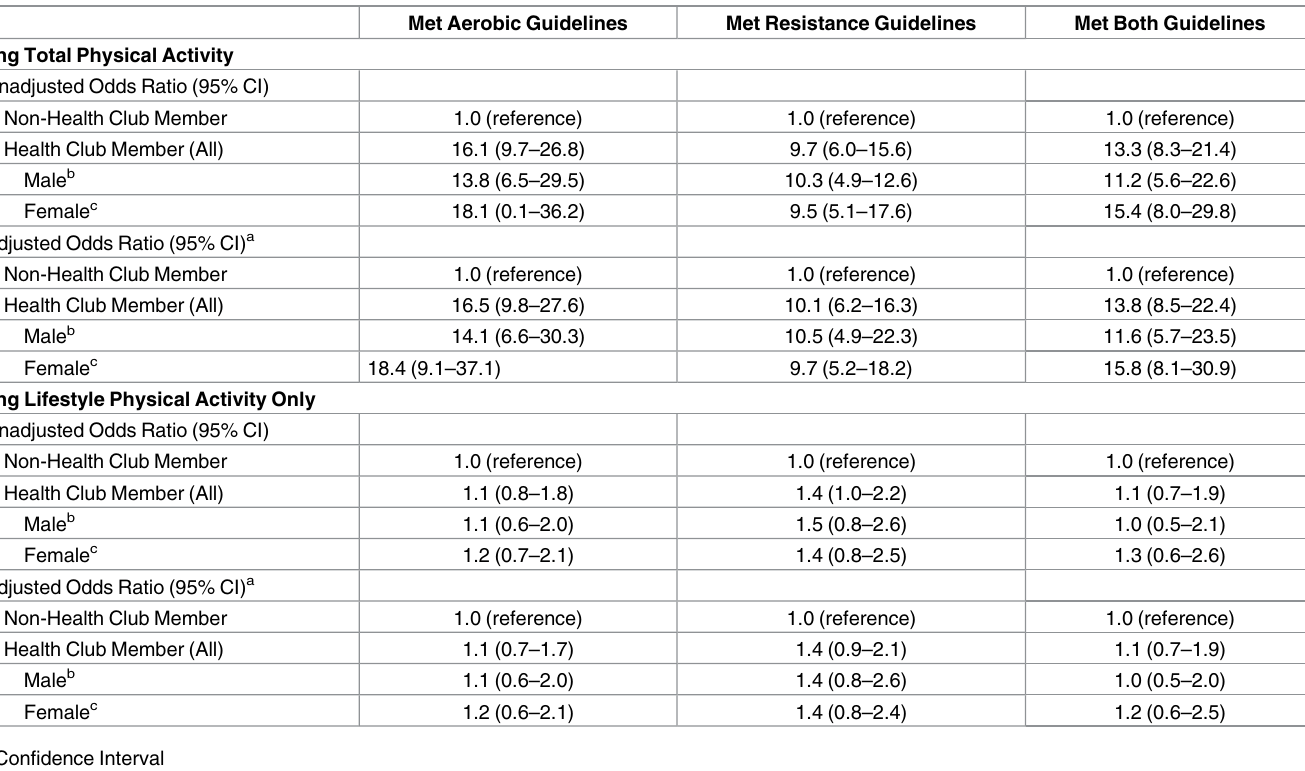
Table 3. Health club membership and meeting the physical activity